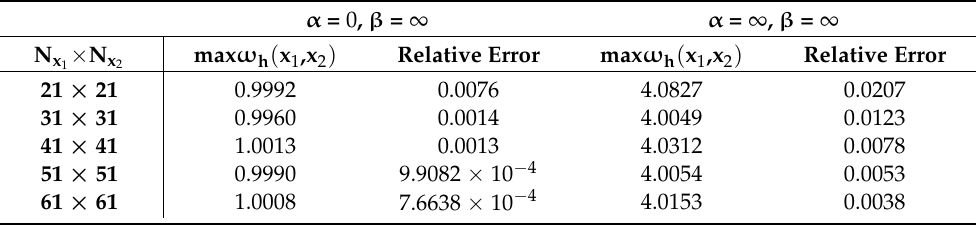
Table 1. The maximal bending (cm) and relative error values obtained on different meshes for different values of α and β